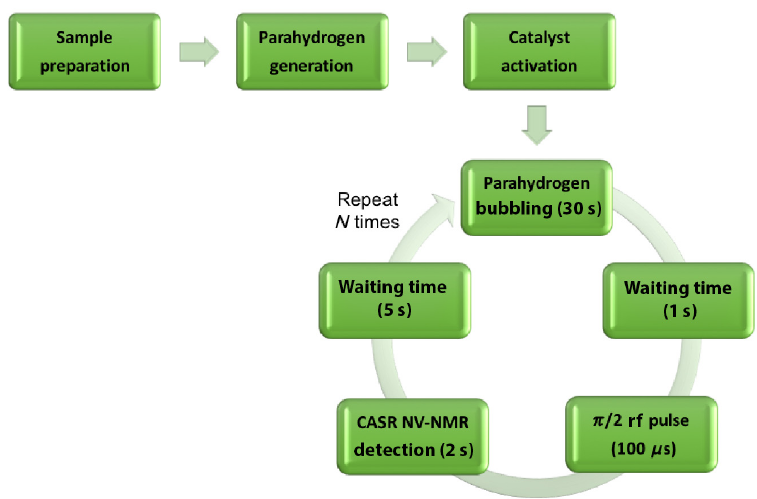
FIG. 9. Experimental protocol. Experimental process such as sample preparation, parahydrogen generation, and catalyst activation are performed only once. NMR measurement, including parahy- drogen bubbling and CASR NV-NMR measure- ment, can be repeated N times, where N is the number of averages used to increase the